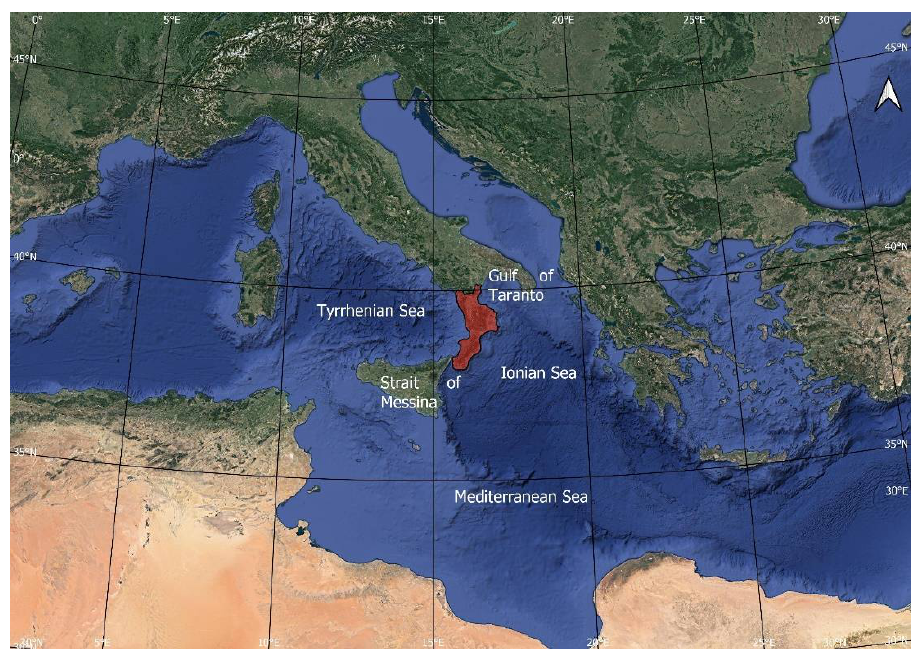
Figure 1. Location of Calabria region (highlighted by the red fill) in Southern Italy in the center of the Mediterranean Sea.